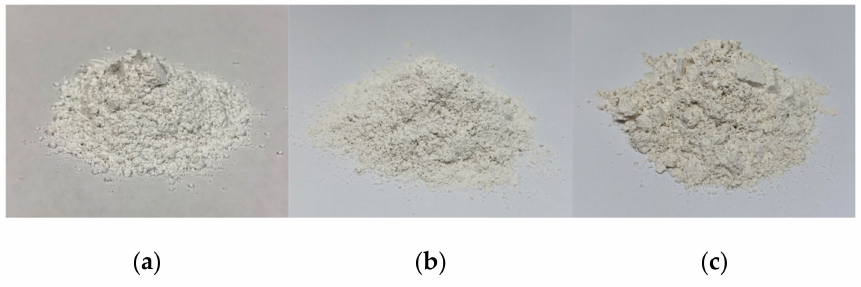
Figure 8. Appearance of body powder ( a ) base body powder ( b ) containing M. acuminata (AAA) ( c ) containing M. sapientum L. (ABB).